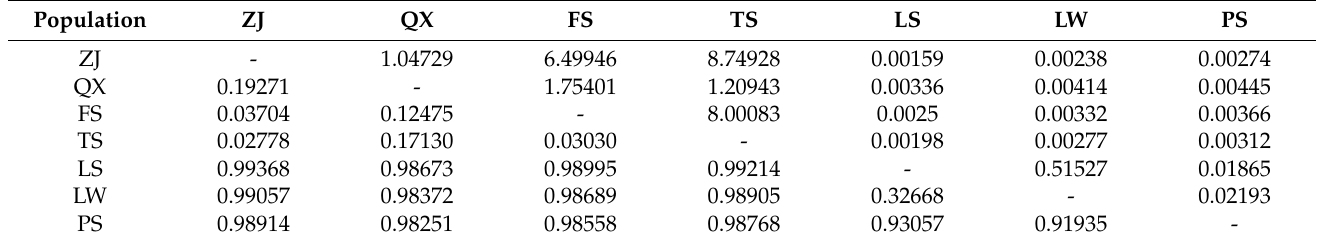
Figure 2. Land use in the Nanjing area and its relationship to the gene flow of S. bungii populations. Table 2. Pairwise gene flow (above diagonal) and F ST value (below diagonal) of the seven populations of S. bungii .